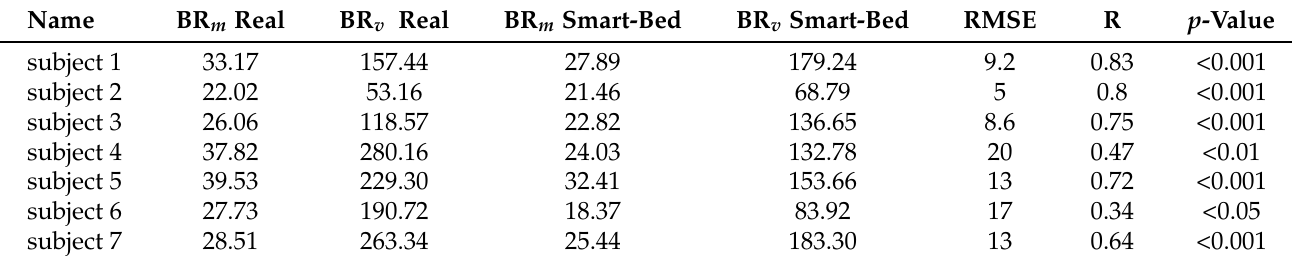
Table 2. For each subject were reported the means of breathing rate estimated with the smart bed (BR m Smart-Bed) and reference cannula signal (BR m Real), the variances of the breathing rate estimated with smart bed (BR v Smart-Bed) and reference cannula signal (BR v Real), the root mean squared error (RMSE), the Pearson’s correlation coefficients (R), and the correspondent p -valueues ( p